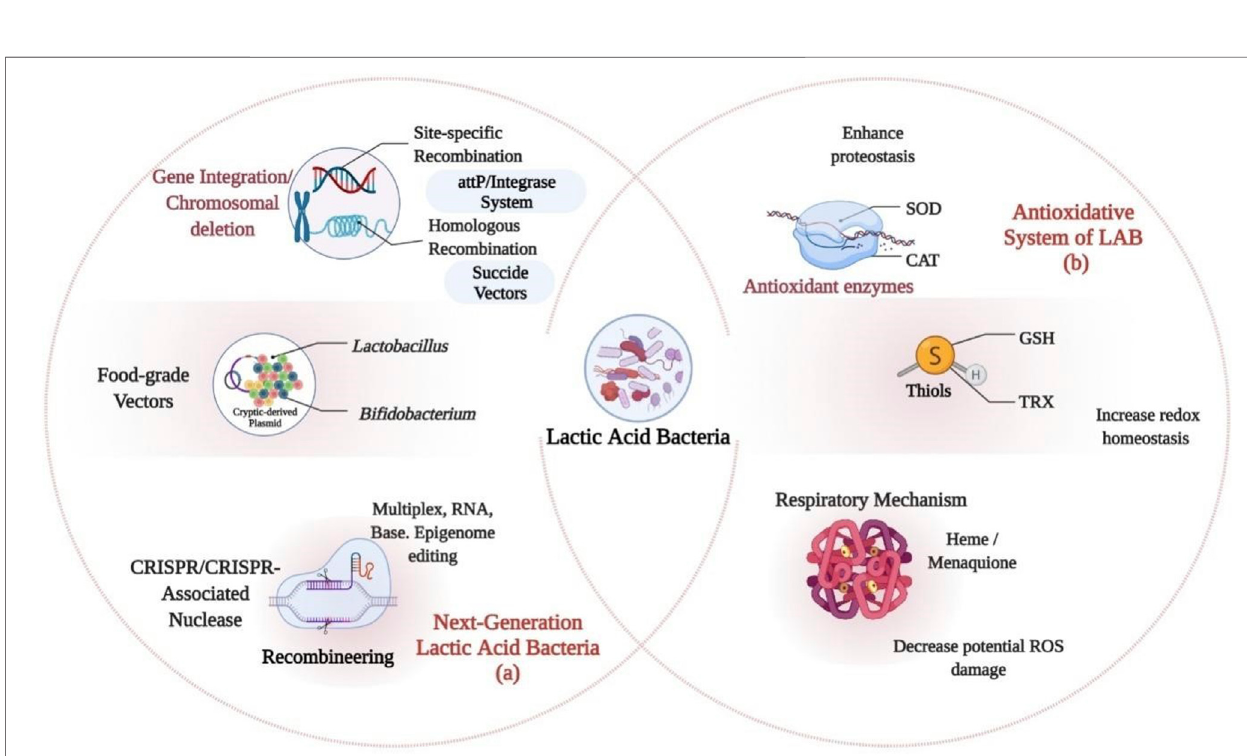
FIGURE 2 | Genomic Approaches and Antioxidative System of Lactic Acid Bacteria (LAB): (A) Genome-based approaches to the characterization of promising probioticstrains. (B) AntioxidativesystemofLAB;Thiols,AntioxidantenzymesandRespiratoryrepertoirewhichallowsthemtowithstandvariousenvironmentalstresses that generates highly reactive species or through the NOX (NADH oxidase) like H 2 O 2 . ROS, Reactive oxygen species; SOD, Superoxide dismutase; GSH, Glutathione; TRX, Thioredoxin-thioredoxin reductase system; CAT, catalase.